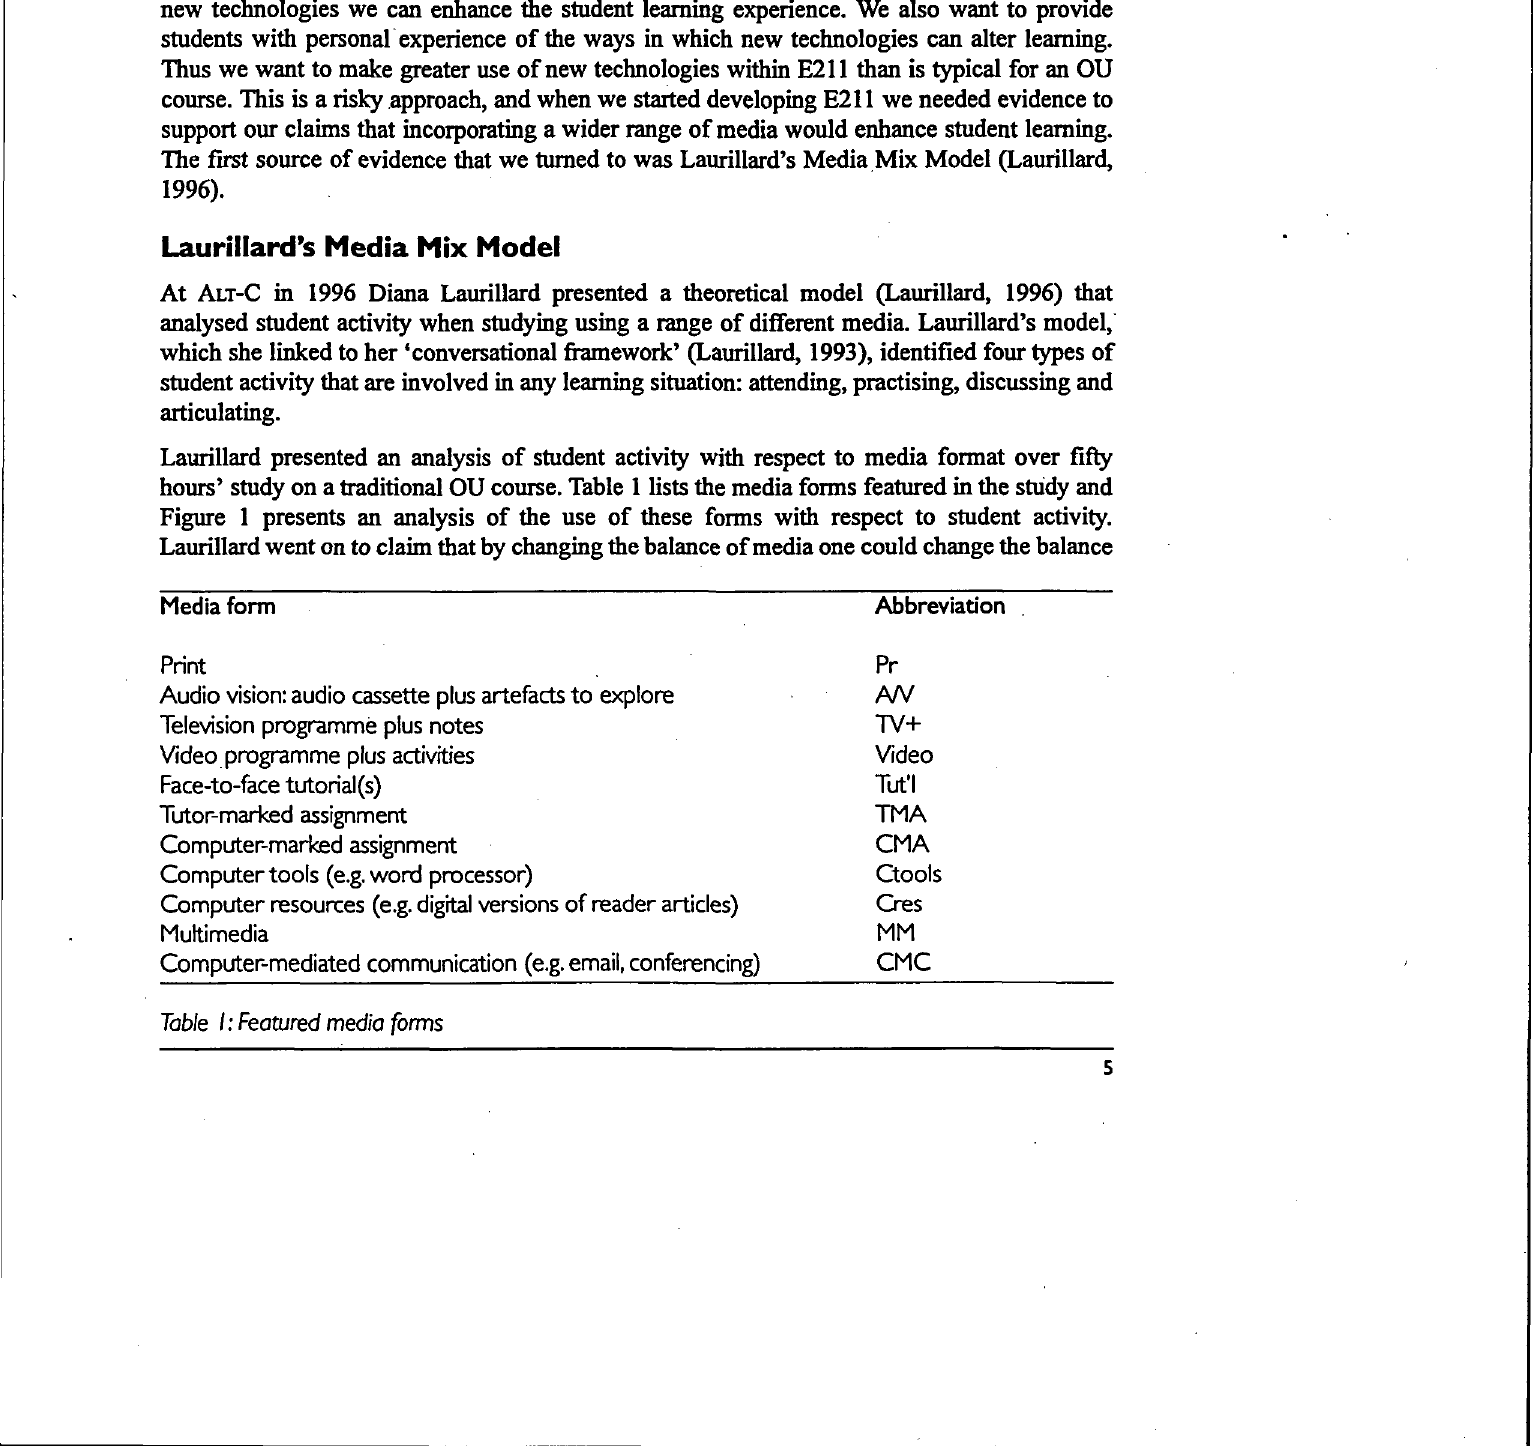
Table I: Featured media